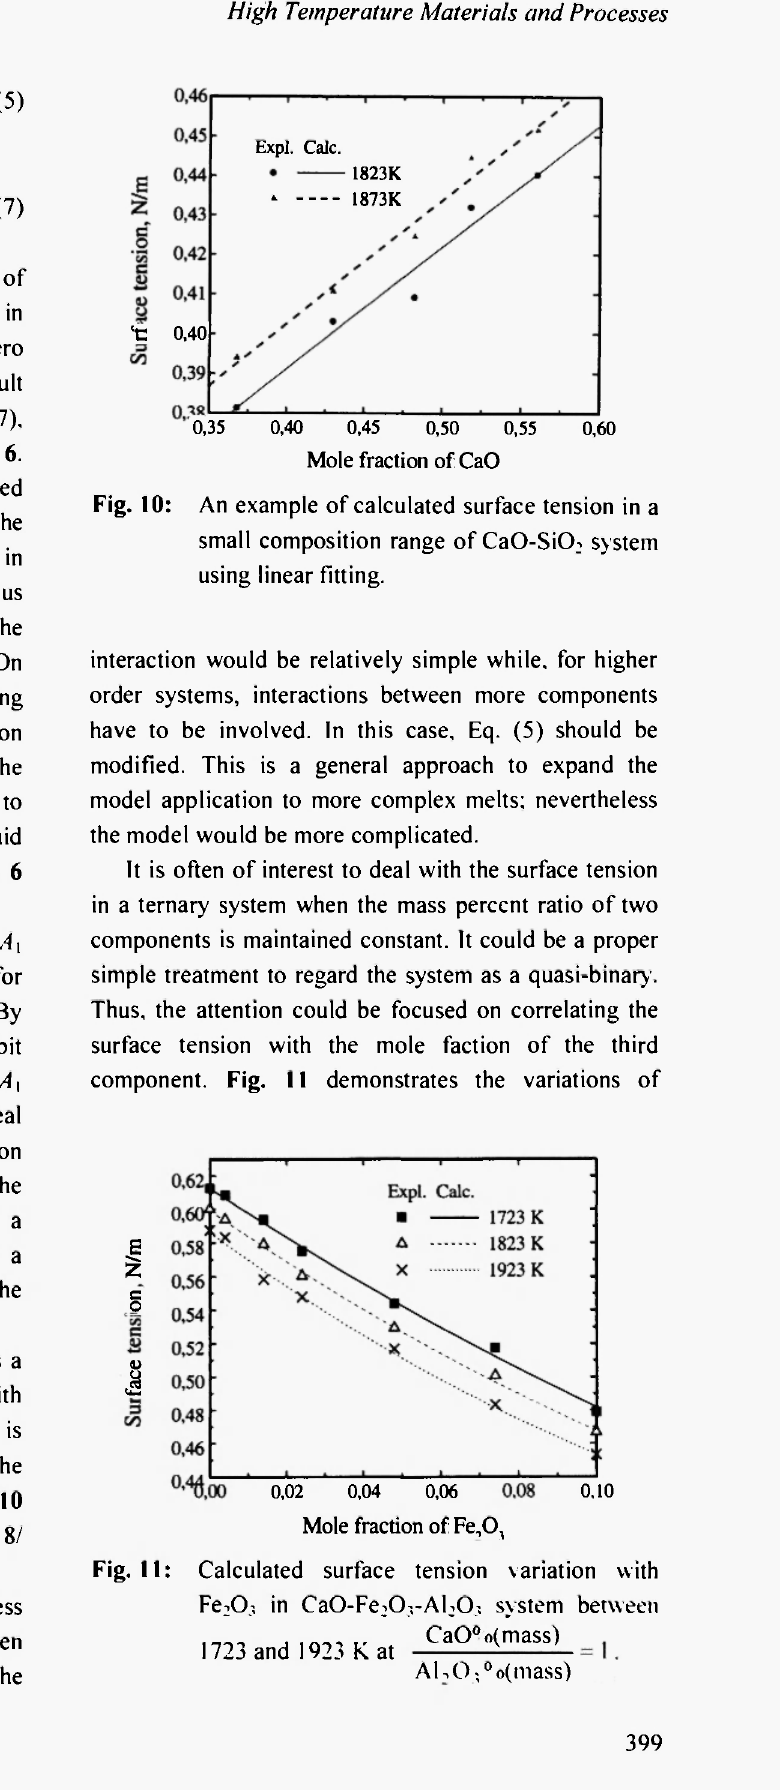
Fig. 10: An example of calculated surface tension in a small composition range of CaO-SiO : system using linear